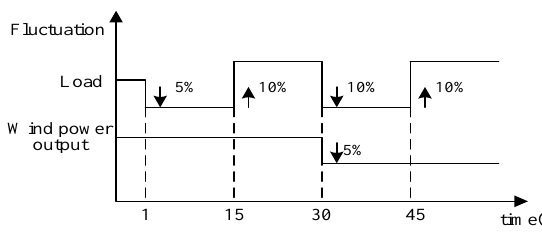
Figure 10. Variations of the load at bus 7 and wind power output.